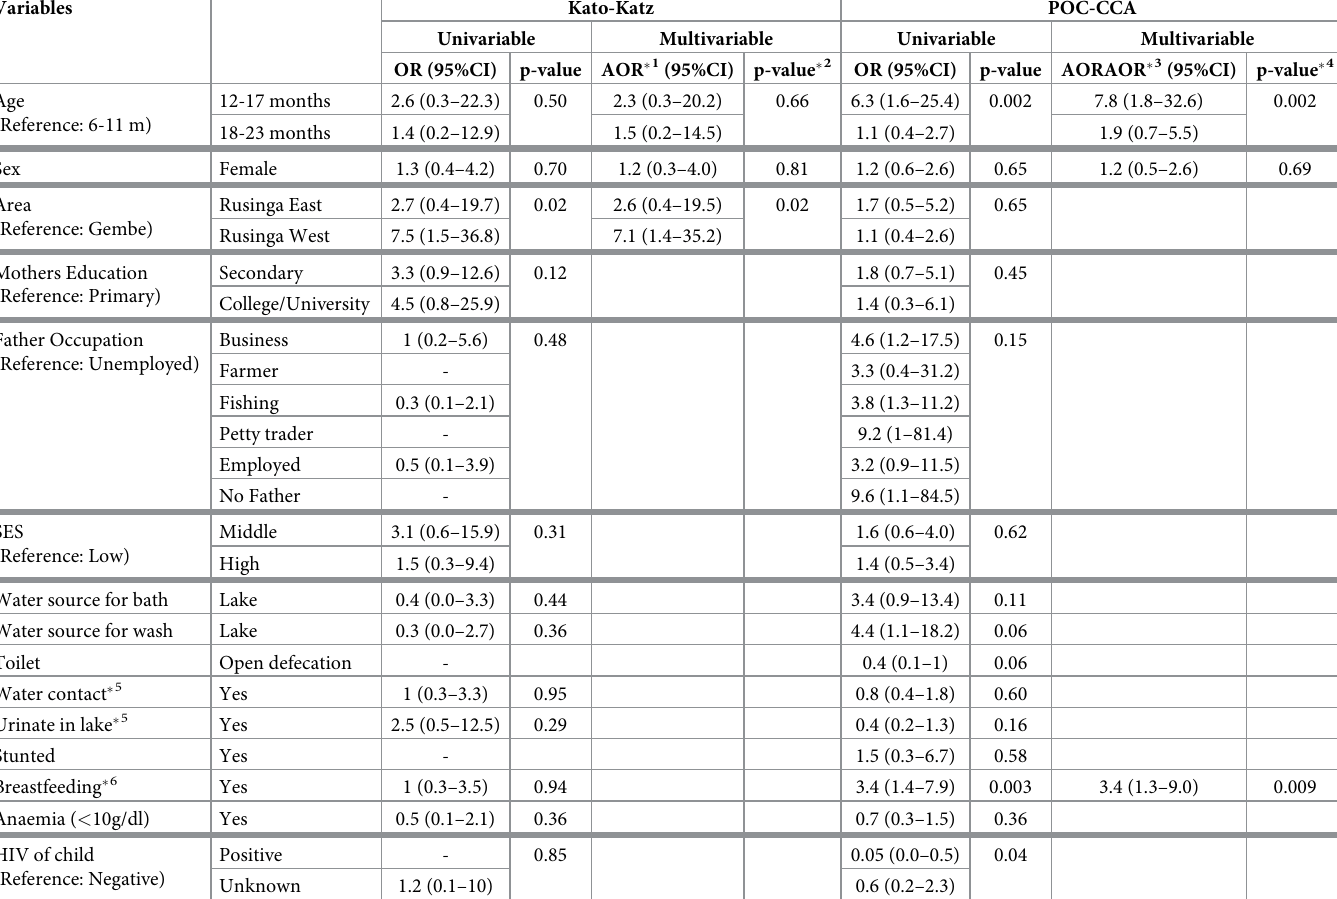
Table 5. Bivariable and multivariable analysis for S . mansoni infection by Kato-Katz and POC-CCA with crude and adjusted odds ratios (95%CI) for each potential risk factor.